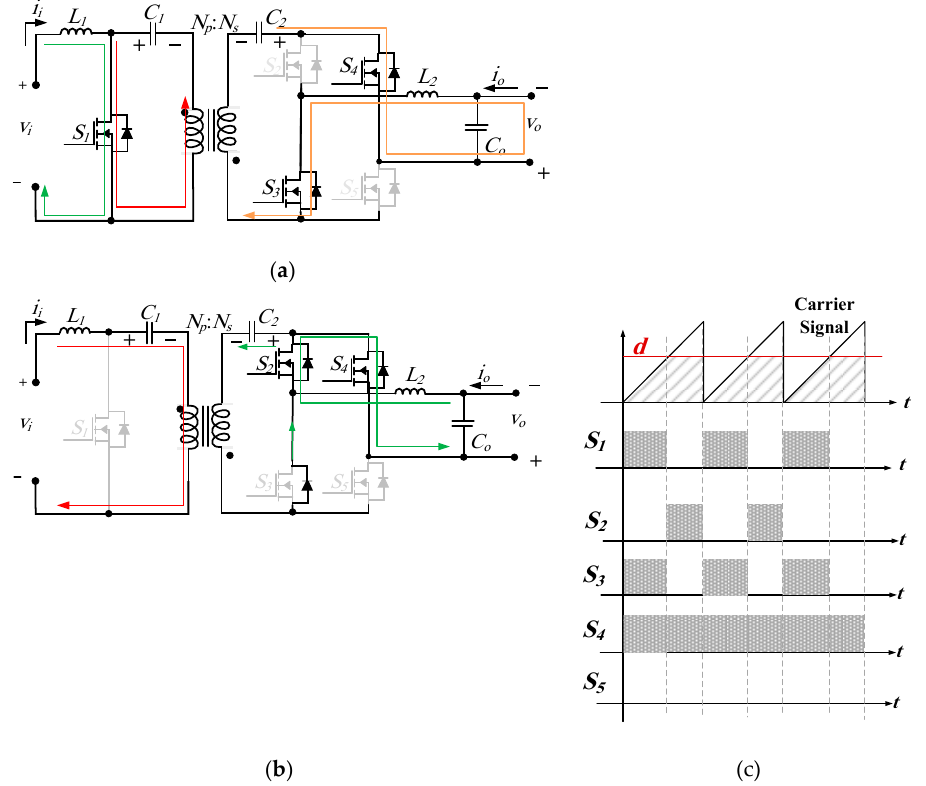
Figure 18. Cuk SM negative half-cycle’s currents during Mode 3: ( a ) St ac1 , ( b ) St ac2, and ( c ) modulation scheme. Gfbfvfihbg bvcxbbbbbbbbcv